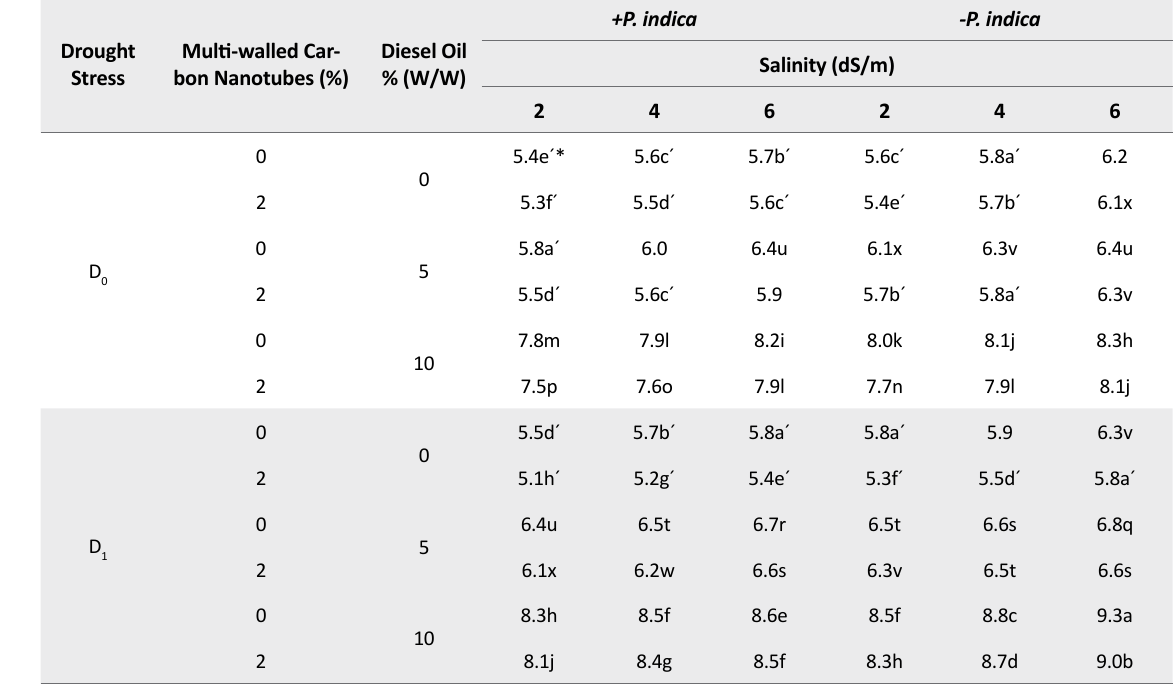
Table 3. The effect of treatments on soil Cd concentration (mg Cd/kg Soil)